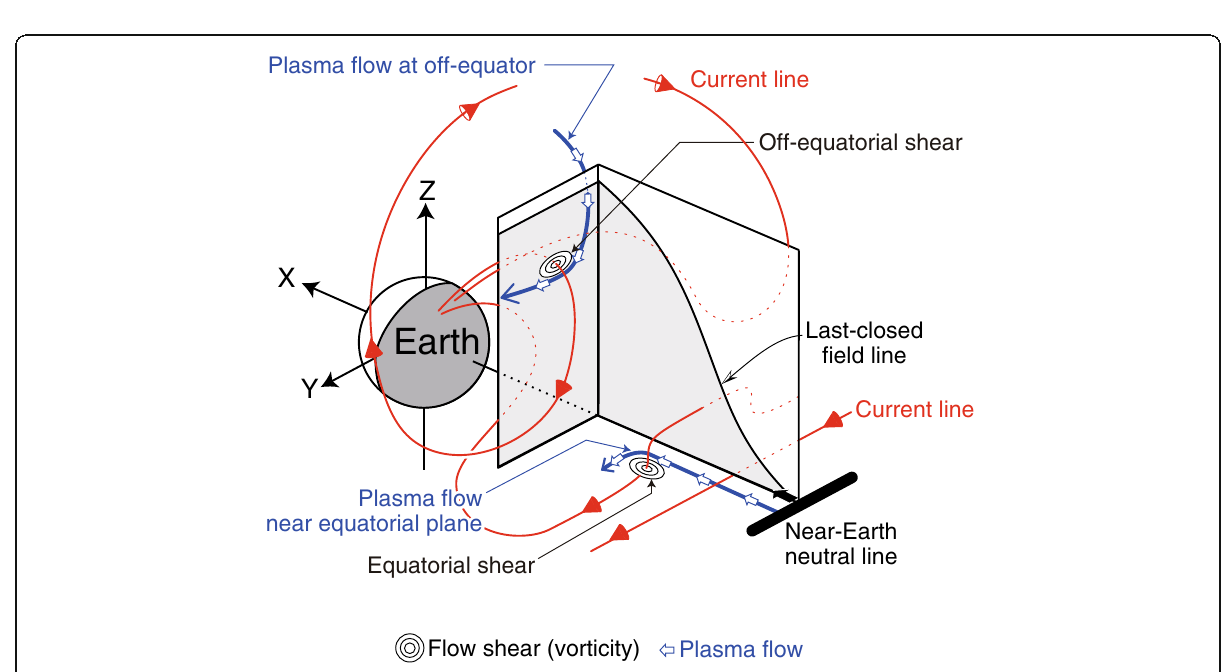
Fig. 10 A schematic of plasma flow (blue line), flow shear (triple circles), and current lines (red line) at the expansion